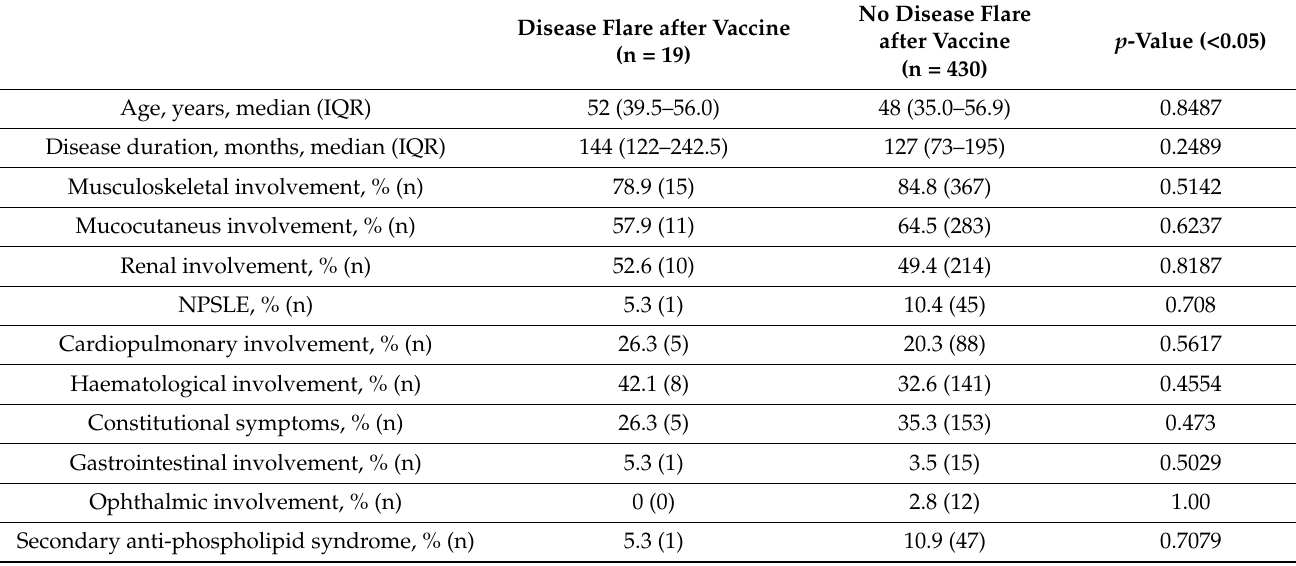
Table 5. Distribution of baseline demographic and SLE patient characteristics according to disease flare after SARS-CoV-2